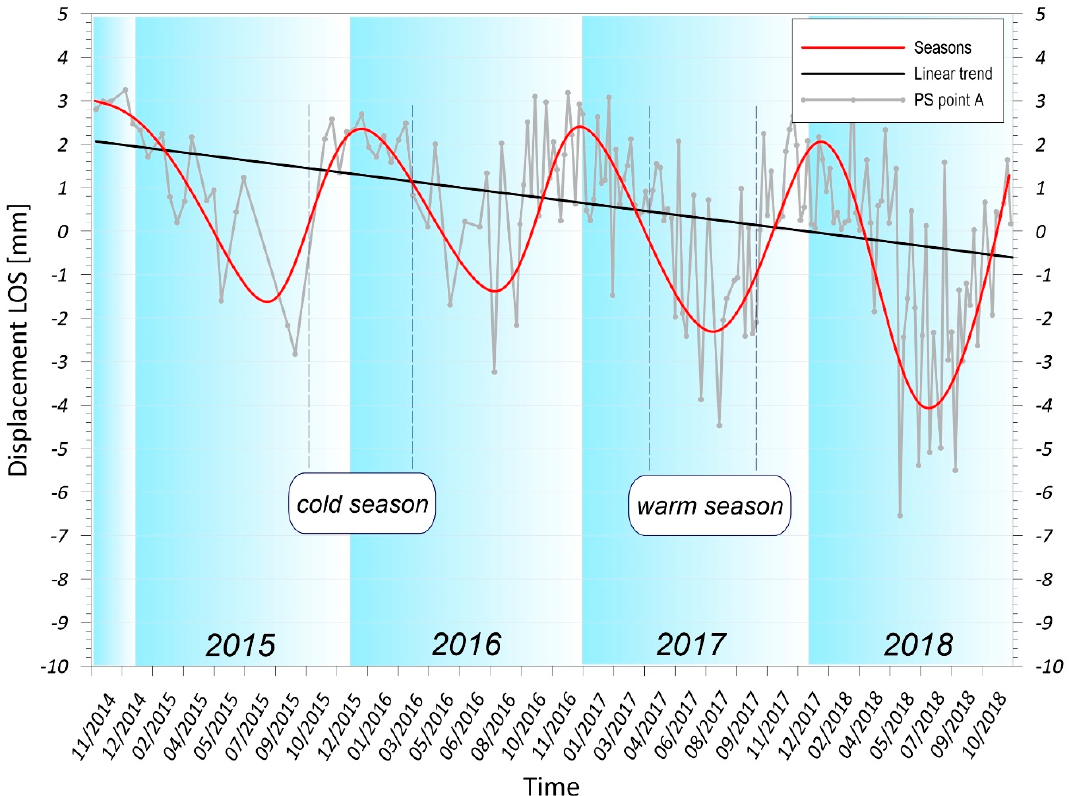
Figure 5. Trend and seasonality accompanying the ground surface movements for the example of the time series of observations of the selected persistent scatter (PS; Point A), see Figure 6 for location.